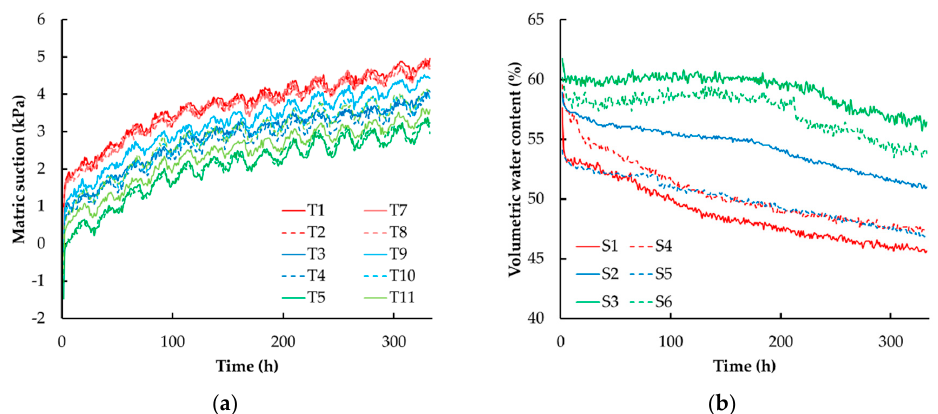
Figure 12. Parameters graphs monitored during the evaporation phase in the horizontal deposit: ( a ) suction; and ( b ) volumetric water content.